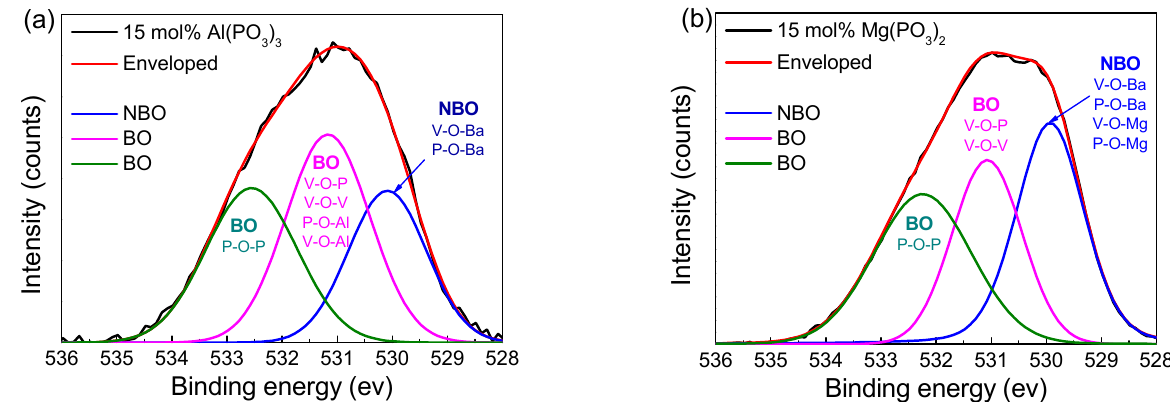
Figure 7. Comparison of the XPS spectra of ( a ) 55V 2 O 5 -5ZnO-22BaO-3B 2 O 3 -15Al(PO 3 ) 3, and ( b )55V 2 O 5 -5ZnO-22BaO- 3B 2 O 3 -15Mg(PO 3 ) 2 . Table 4. Peak positions and area from the curve fitting of O 1s core levels for 55V 2 O 5